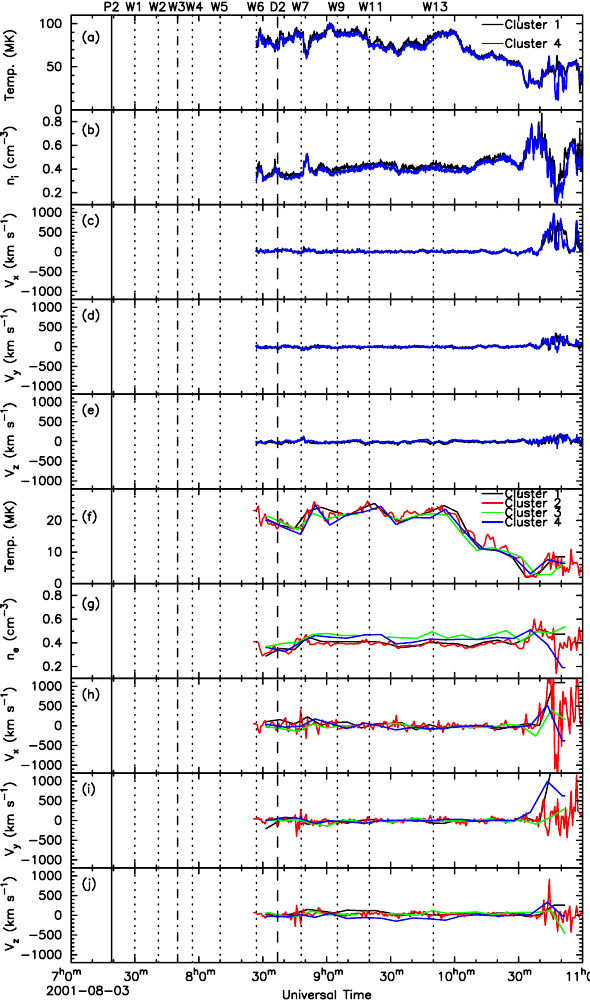
Fig. 9. Plot of particle moments from the Cluster CIS and PEACE instruments (Cluster 1: black, Cluster 2: red, Cluster 3: green, Clus- ter 4: blue). Panels (a–e) show ion moments from the CIS instru- ments. Panels (f–j) show moments from the PEACE instruments. The plots show (a–e and f–j, respectively) the temperature, density, V X , V Y and V Z components.